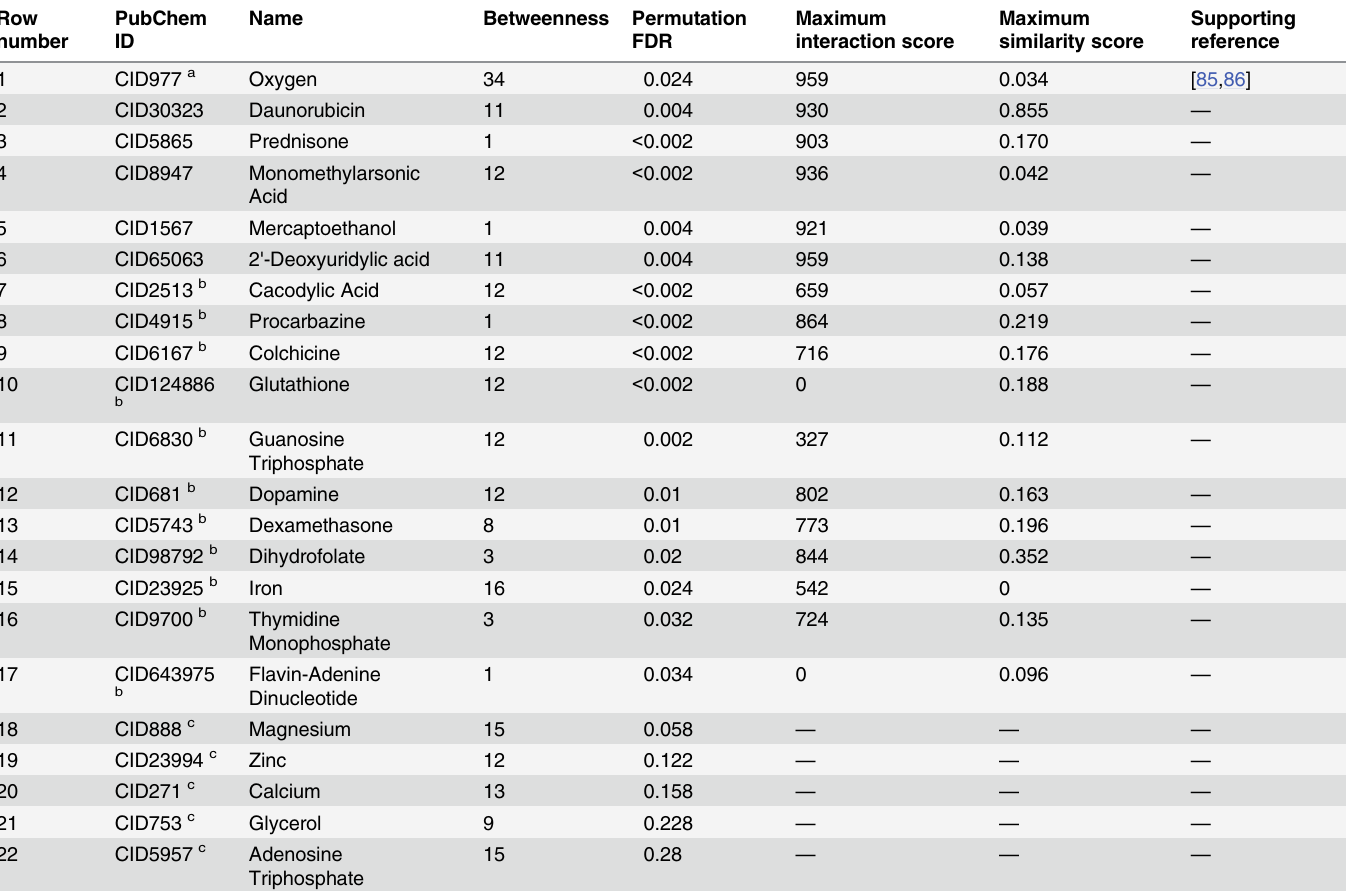
Table 3. Detailed information of 22 candidate chemicals for